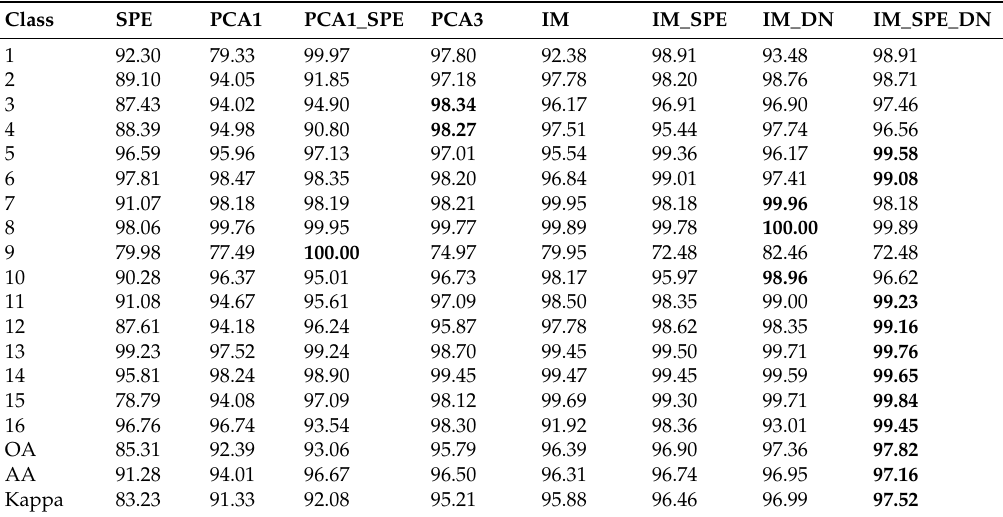
Table 1. The classification results on Indian pines dataset (%).